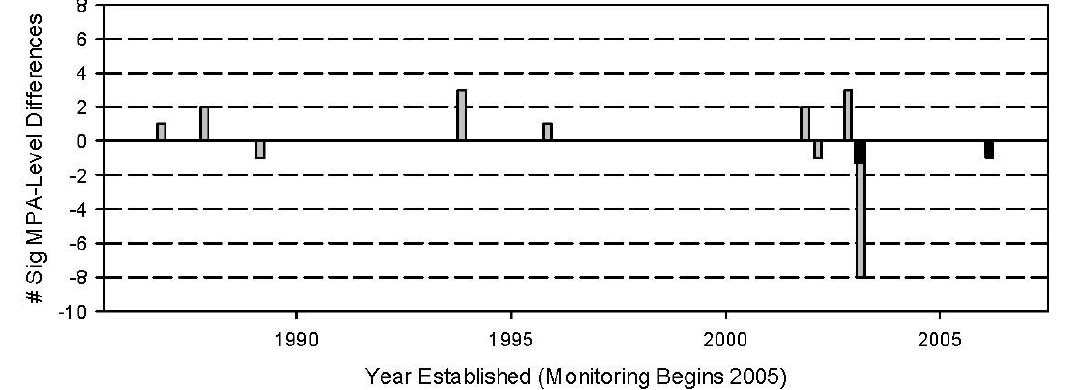
Figure 4. The relationship between the occurrence of significant differences in the body size frequency distribution and MPA age. Grey bars above y = 0 represent the number of MPAs of a given age that demonstrated a significant shift in body size distribution compared to fished reefs. Grey bars below y = 0 represent the number of MPAs of a given age that did not show a significant difference in body size distributions. Black bars below the x-axis represent MPAs that demonstrated a significant shift in body size distributions towards larger body sizes of fishes in fished reefs compared to fishes within MPAs. Results of a contingency table analysis revealed no significant association between MPA size and body size frequency shifts (χ 2 = 11.6; d.f. = 8; p =